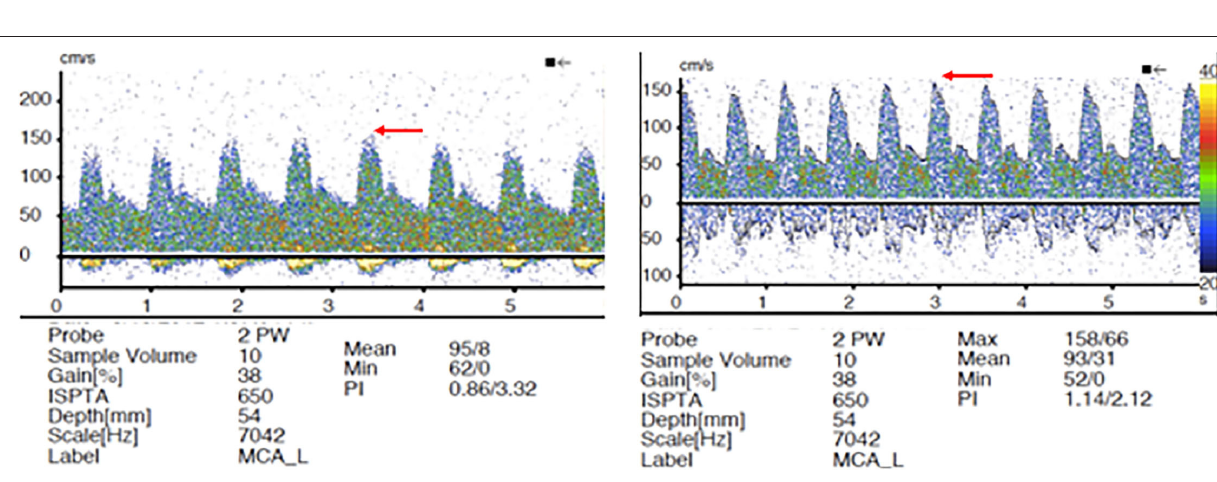
Frontiers in Neurology |